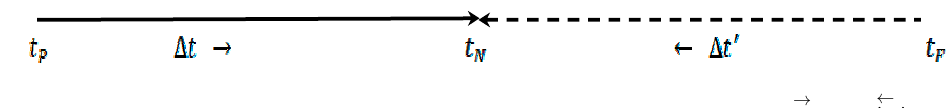
Figure 3. The generation of contradiction induced by opposite transmission of 𝚥, 𝑘(cid:4652)(cid:4652)(cid:4652)(cid:4652)(cid:4652)⃗ and 𝑘 (cid:4593) , 𝚥 (cid:4593) ⃖(cid:4652)(cid:4652)(cid:4652)(cid:4652)(cid:4652)(cid:4652)(cid:4652)(cid:4652)(cid:4652) .